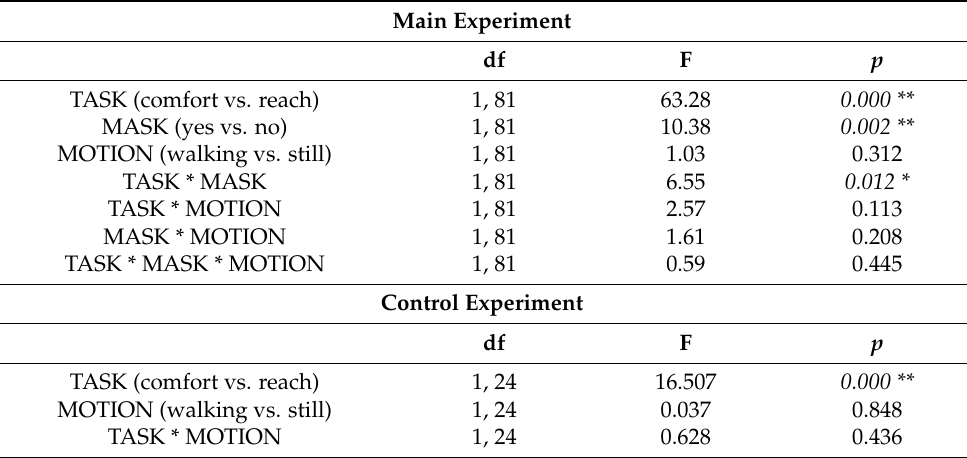
Table 3. ANOVAs comparing comfort and reaching distance in the different conditions. Upper: main experiment; Lower: control experiment.